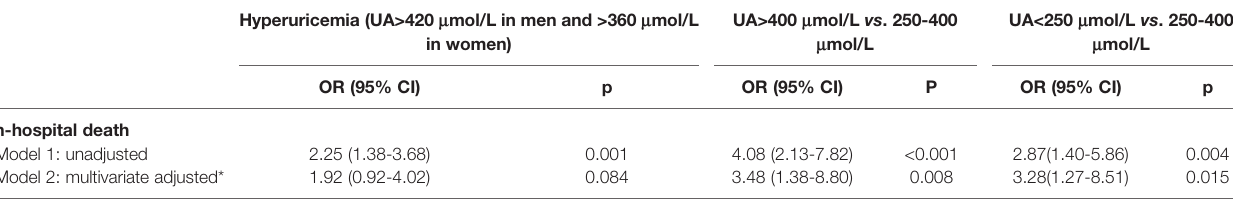
TABLE 2 | Univariate and multivariate logistic regression analysis for in-hospital mortality.